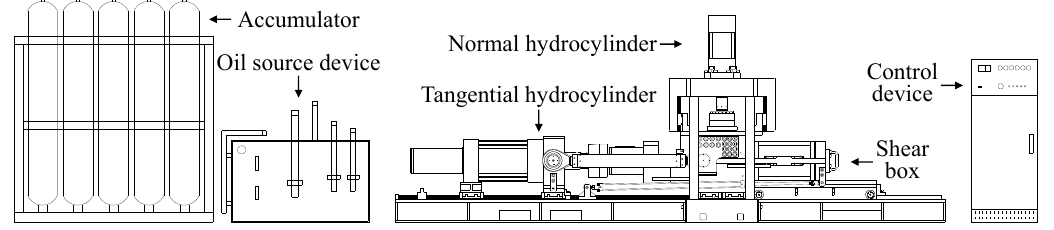
Figure 1. Hardware schematic of the test platform [58,59].